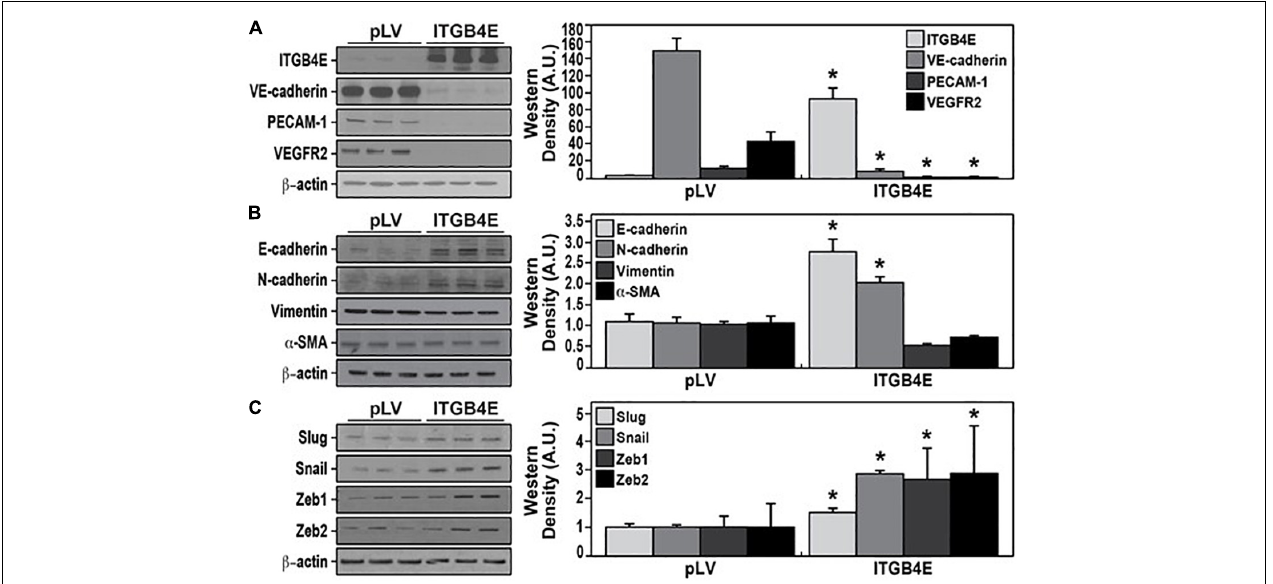
FIGURE 4 | Overexpression of ITGB4E promotes endothelial-to-mesenchymal transition (EndMT). Human pulmonary artery ECs were transfected with ITGB4E or a control vector and lysates were then collected and subjected to Western blotting for (A) EC markers including VE-cadherin, PECAM-1, and VGFR2; (B) mesenchymal transition markers including E-cadherin, N-cadherin, vimentin, and alpha-smooth muscle actin ( α -SMA); and (C) transcription factors known to mediate EndMT including Snail, Slug, Zeb-1, and Zeb-2 ( n = 3 independent experiments, * p < 0.05 compared with respective